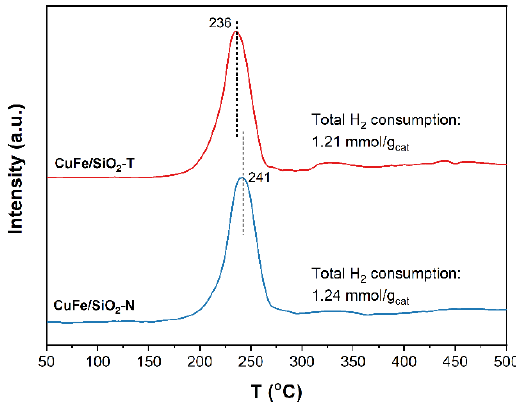
Figure 4. H 2 -TPR profiles of CuFe/SiO 2 catalysts before and after treatment.